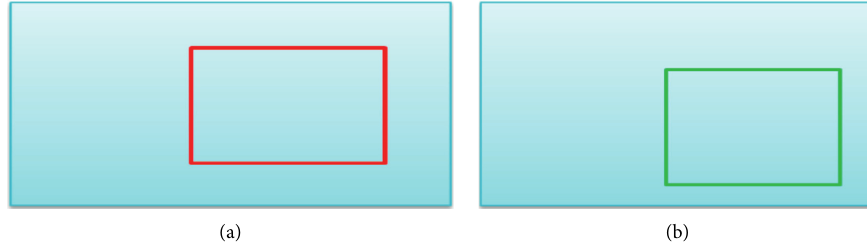
Figure 6: Ground truth boundary box: (a) ground truth and (b) the boundary box detected by